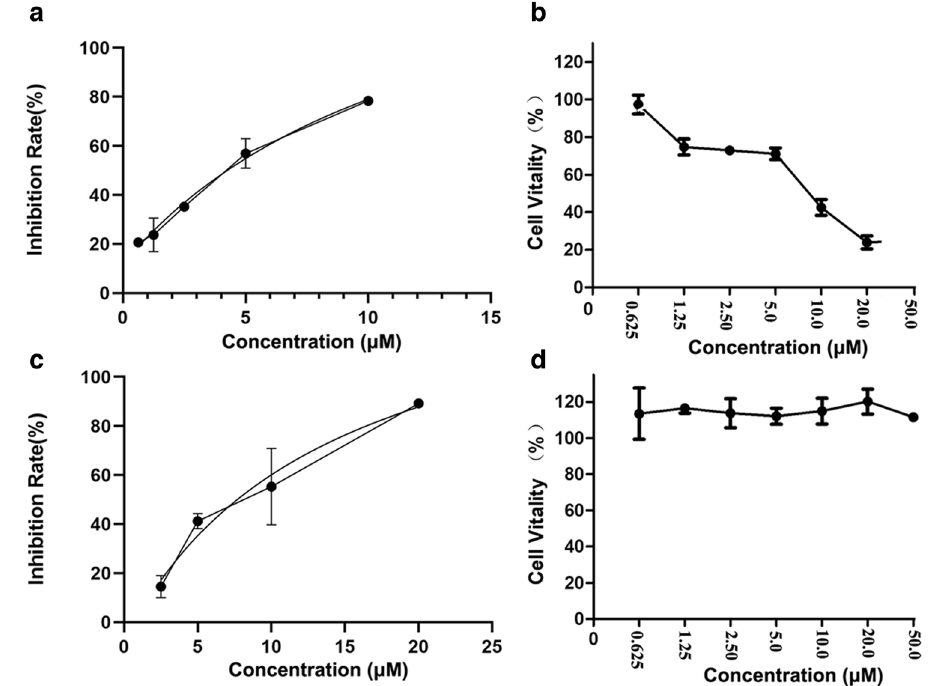
Fig. 9 | The antiviral activity. a 13 inhibited the growth of HIV-1 virus in dose dependentmannerinSupT1cell; b13 exhibitedmoderatecytotoxicitywithCC 50 of 8.22 µ M for SupT1 cell; c 4a inhibited the growth of IAV virus in dose dependent manner in 293T-GLUC cell; d 4a exhibited low cytotoxicity for 293T-GLUC cell.